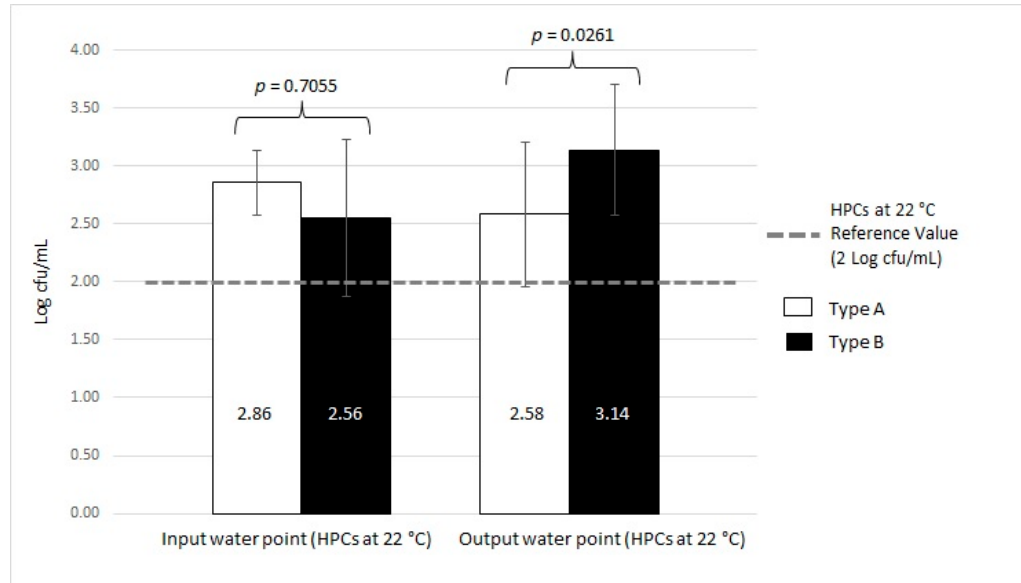
Figure 9. Microbiological contamination in Type A and Type B input vs. output samples using HPC analysis at 22 °C.